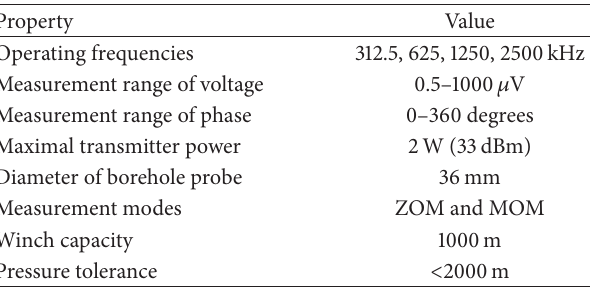
Table 1: Information on the EMRE